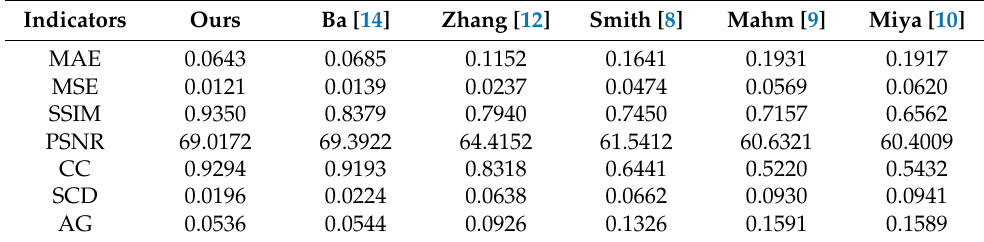
Table 2. Comparison of multiple metrics between different